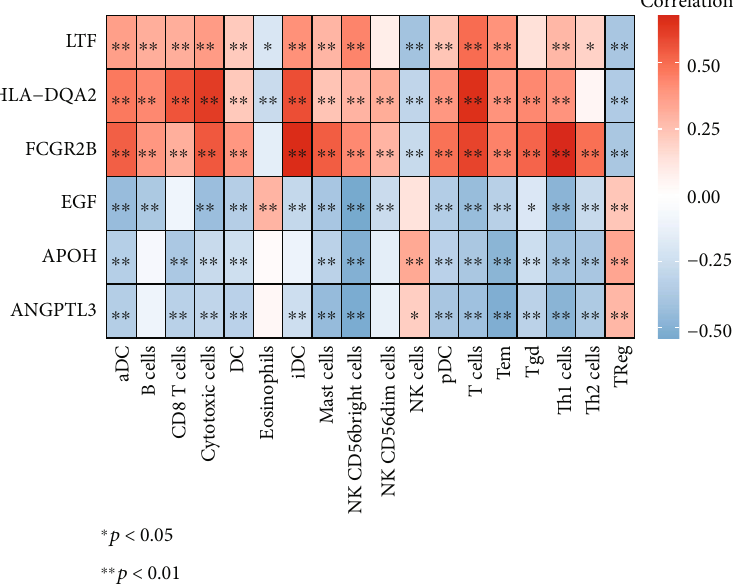
Figure 5: Correlation analysis between diagnostic genes and di ff erentially expressed immune in fi ltrating cells. The correlations between diagnostic genes and di ff erentially expressed immune in fi ltrating cells. The greater the correlation, the deeper the color (red is positive correlation and blue is negative correlation; ∗ P < 0 : 05 and ∗∗ P < 0 : 01